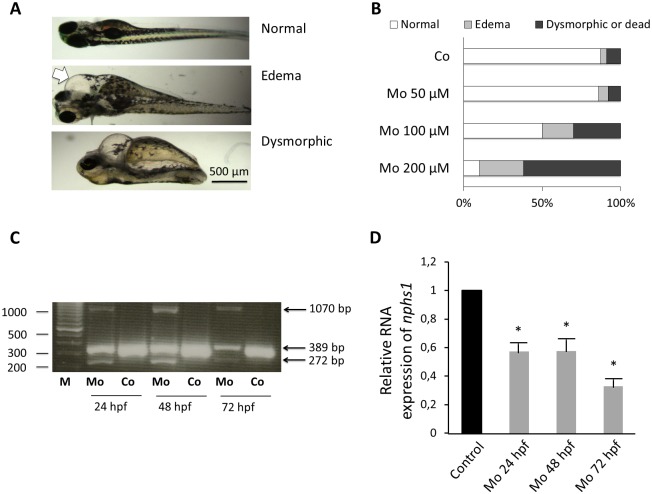
Phenotype and nephrin expression in nephrin depleted zebrafish.(A) Three categories of phenotypes were defined in nephrin morpholino injected embryos: embryos without edema (normal), embryos with visible pericardial edema (white arrow) and dysmorphic or dead embryos. Pictures were taken at 5 dpf. (B) 80 embryos per condition were live-screened at 5 dpf and assigned to a phenotype category. Increasing concentrations of the injected nephrin morpholino were associated with an increasing percentage of embryos with pericardial edema, but also with increased numbers of severely dysmorphic or dead embryos. (C) RT-PCR was performed using total RNA extracted from nephrin morpholino (100 μM) and control morpholino injected embryos at 24, 48 and 72 hpf. Reduced expression of normal nephrin (389 bp) was found in the nephrin depleted versus control embryos. Moreover, injection of nephrin morpholino induced alternative splicing resulted in 272 and 1070 bp fragments, resulting from an exon deletion and a retained intron, respectively. (D) Quantitation of nphs1 RNA expression in control versus nephrin morpholino injected larvae after 24, 48 and 72 h of injection. M, marker; Mo, nephrin morpholino injected; Co, control morpholino injected.